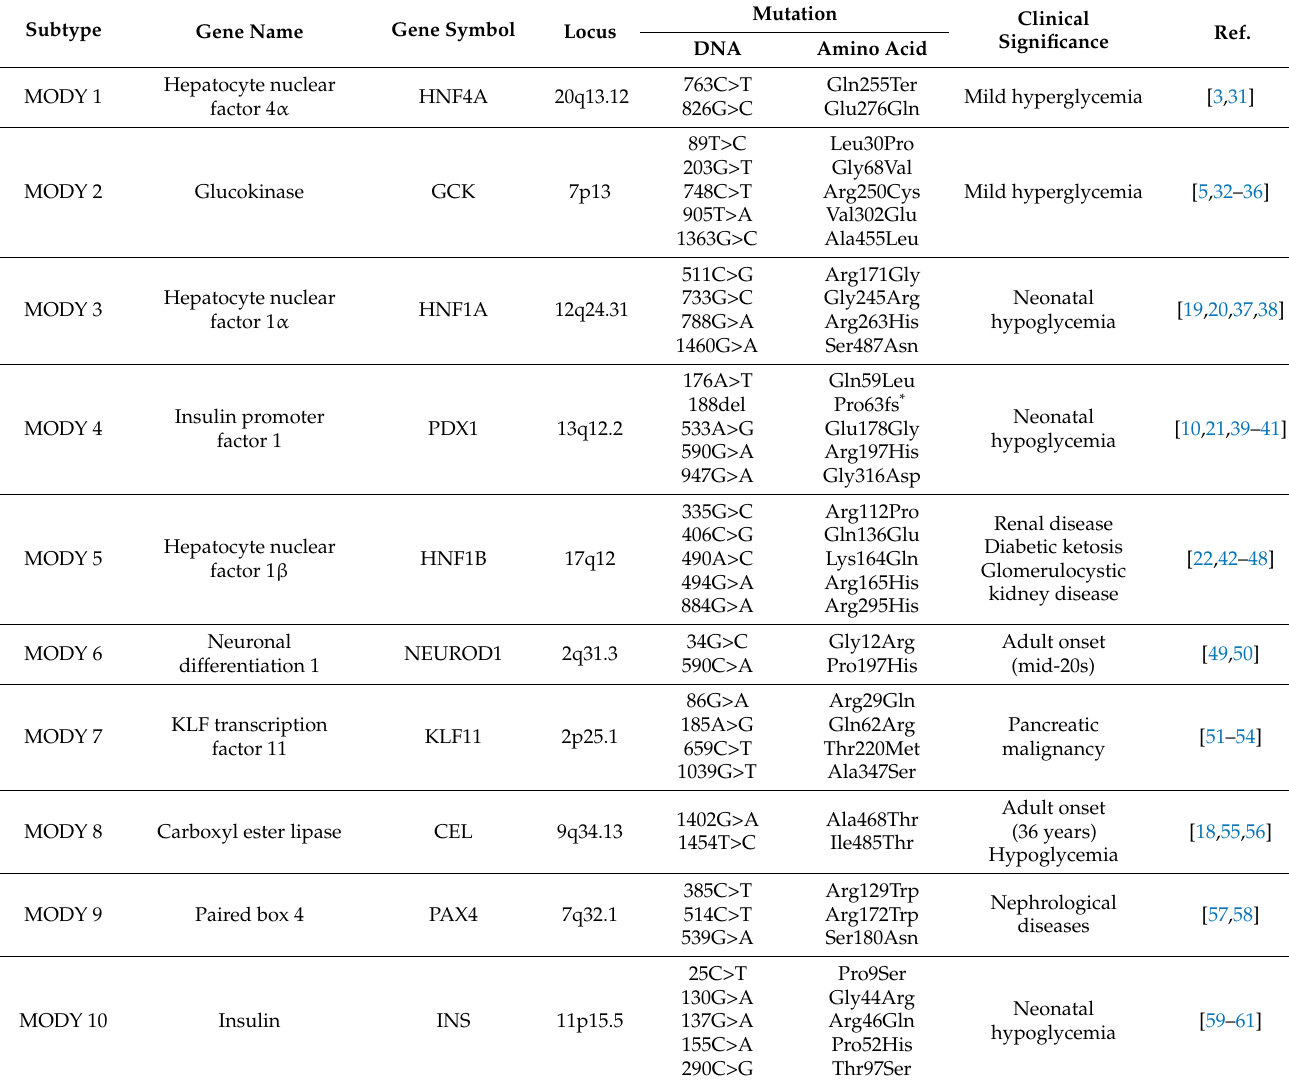
Table 1. Genetic mutations and clinical significance in MODY